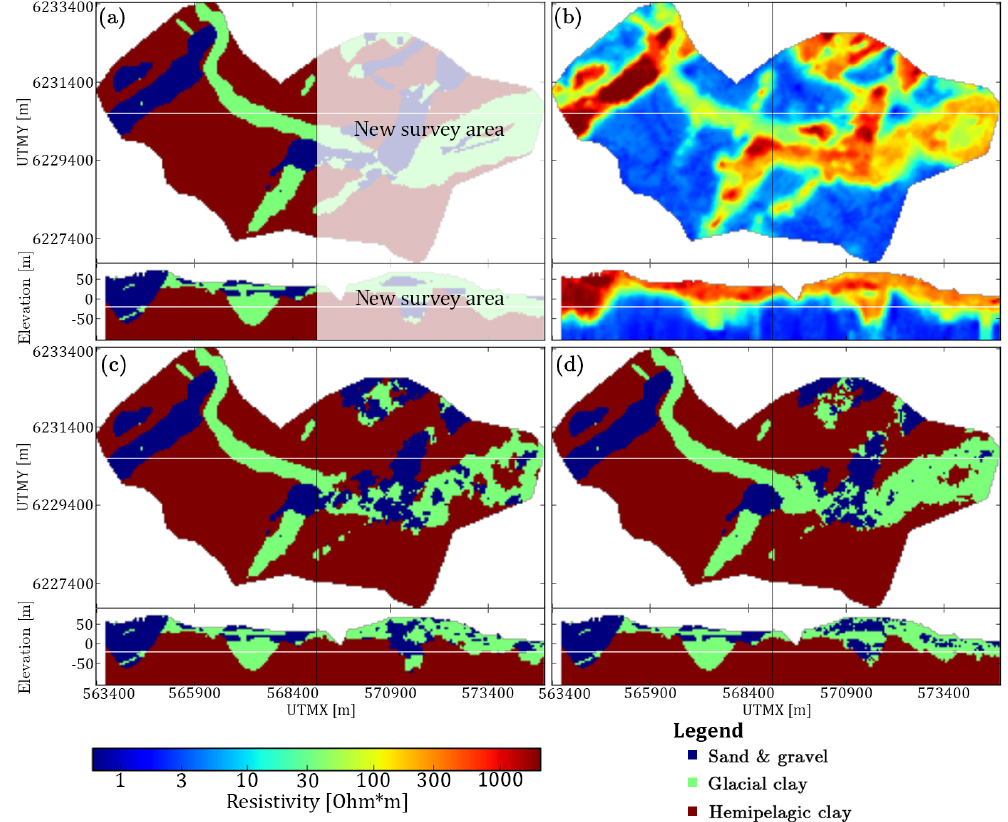
Figure 11. An overview of the setup for simulating new survey areas and the hydrostratigraphic modeling results using the Kasted dataset. The presented horizontal slices are centered on 20mb.s.l., and the vertical cross section intersects at UTMY 6230150m. (a) The cognitive hydrostratigraphic model is cut in half to simulate having two survey areas, one area with a cognitive hydrostratigraphic model (training image) available and the other without. The white area represents the new survey we wish to simulate. (b) The horizontal slices and vertical cross sections of the soft data used to simulate the new area. The left half is the auxiliary variable, while the right half constrains the simulation of the new survey area. (c) A single hydrostratigraphic realization. The left half is exactly the same as the cognitive model, see (a) , while the right half is simulated using DS. (d) The mode of an ensemble of 10 hydrostratigraphic model realizations. Again, the left haft is the same as the training image and the right half shows the ensemble mode of 10